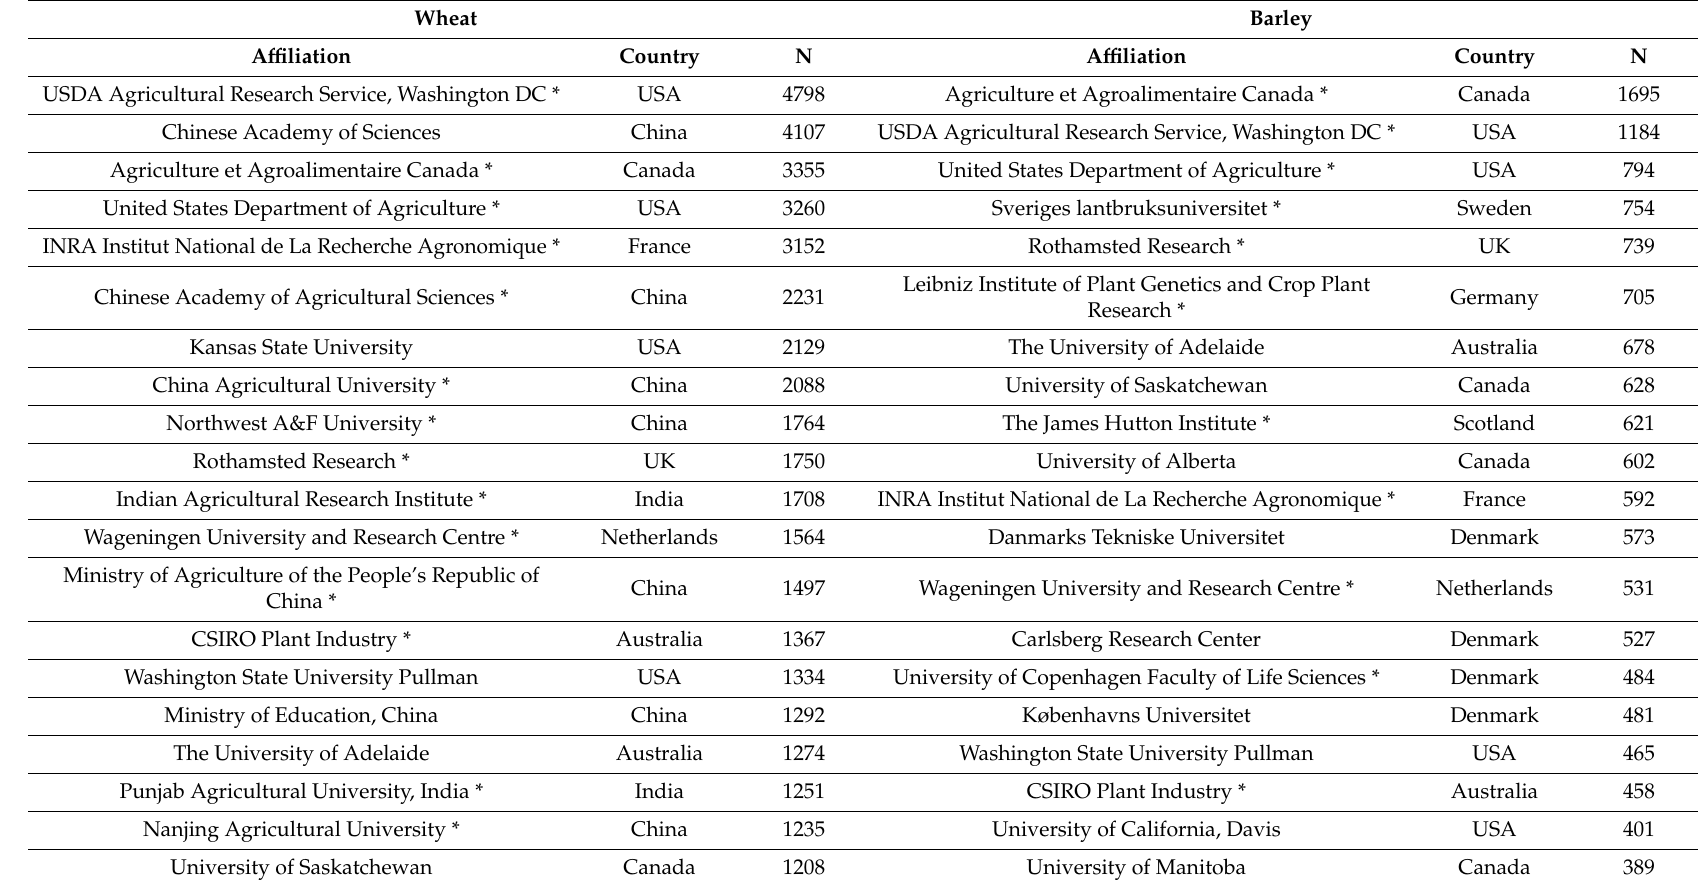
Table 2. Rankings of the 20 most productive institutions in the wheat and barley research fields. Institutions included in both lists are in bold lettering. Wheat Barley A ffi liation Country N A ffi liation Country